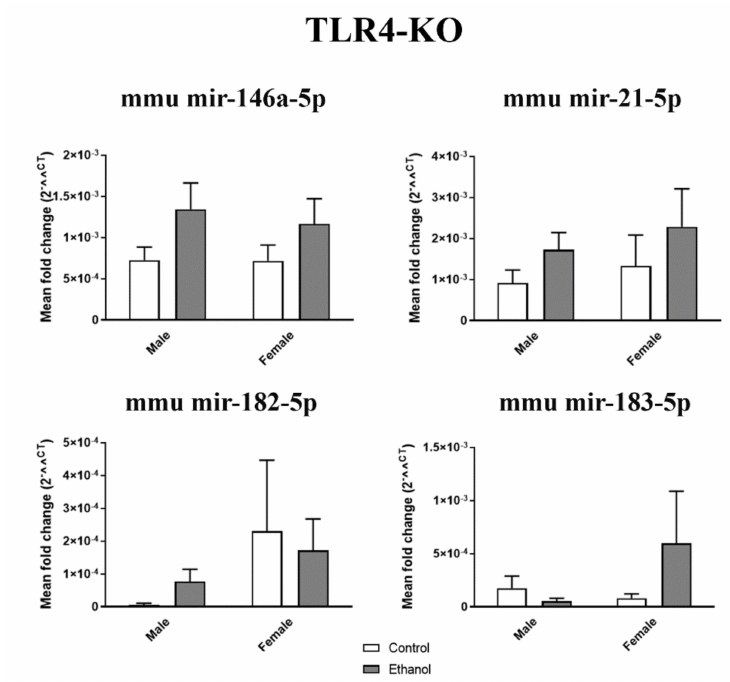
Figure 3. Inflammatory-related miRNA profile in the plasma EVs deriving from the ethanol-treated adolescent toll-like receptor 4 (TLR4)-knockout (KO) mice. Graphs represent the expression of plasma EV miRNAs (mir-146a-5p, mir-21-5p, mir-182-5p, and mir-183-5p) after the ethanol or saline treatment in the adolescent female and male TLR4-KO mice (PND 44). Data represent mean ± SEM, n = 6 independent experiments. No significant di ff erences were shown, according to the two-way ANOVA followed by the Bonferroni post hoc